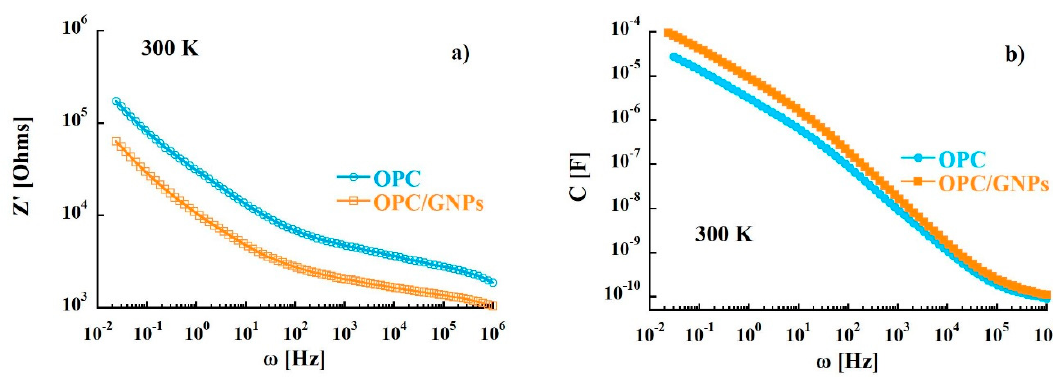
Figure 3. ( a ) Dependence of the real part of the complex impedance function as a function of frequency. ( b ) Frequency dependence of capacitance at 300 K.